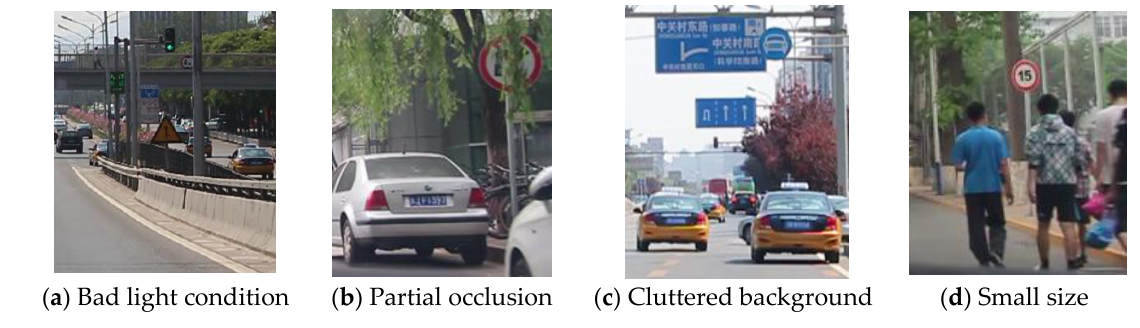
Figure 1. Problems of traffic sign detection.